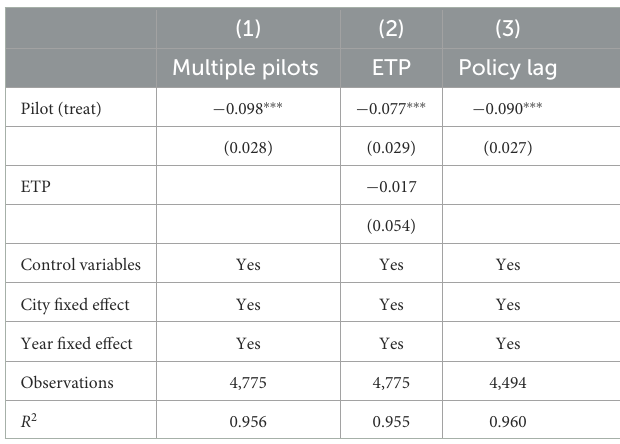
TABLE 4 Robustness